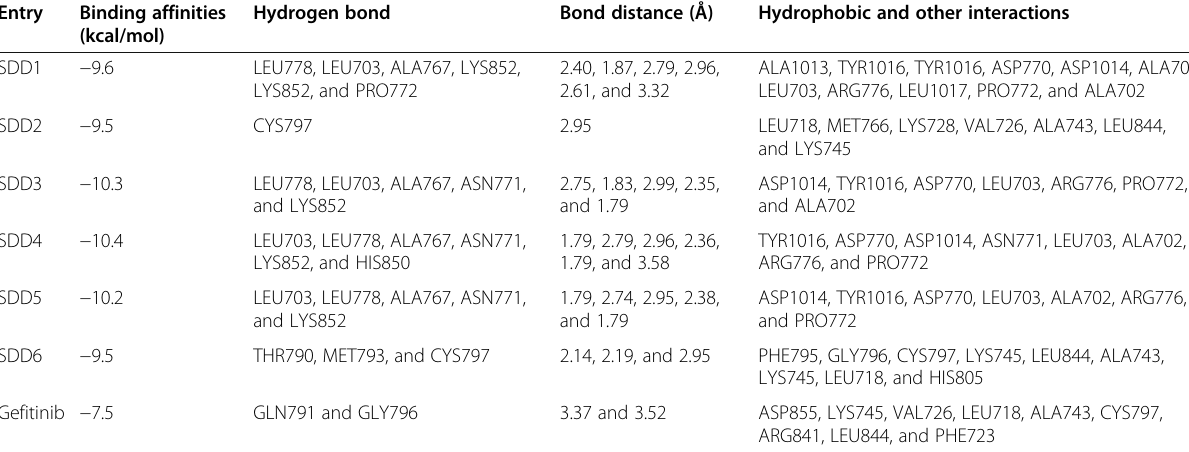
Table 3 Types of interactions of newly designed EGFR